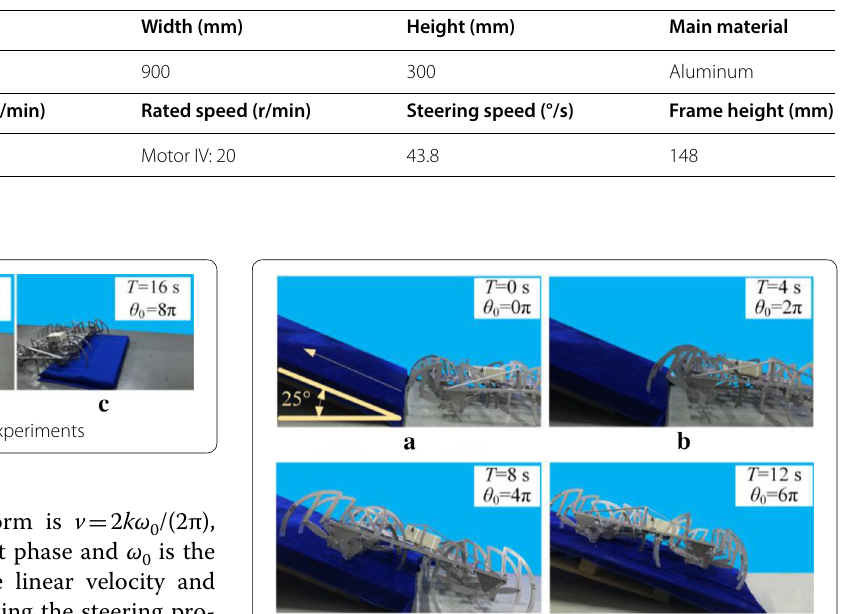
Table 5 Specifications for the platform